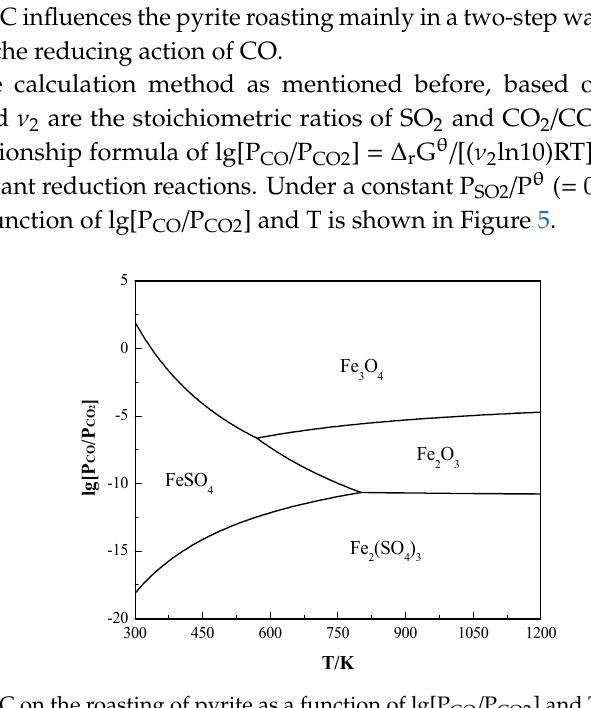
Figure 5. Effect of C on the roasting of pyrite as a function of lg[P CO /P CO 2 ] and T under P SO 2 /P θ =